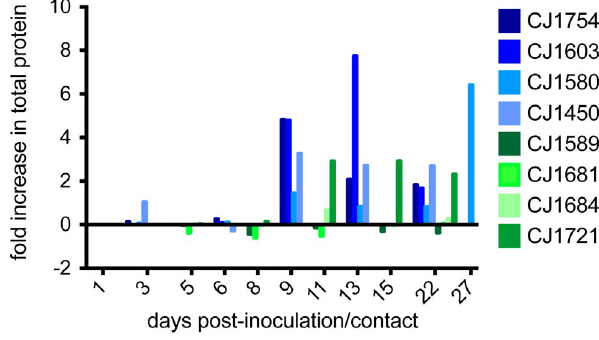
Figure 4. Protein is secreted into BAL fluid as influenza infection progresses. Bradford assay was used to detect secretion of proteins into the lungs as an indicator of damage to lung tissue. Values were normalized to protein levels detected on the first day BALs were collected. Data on subsequent days are expressed as fold increase over this baseline level; therefore negative values on this scale indicate decreased protein concentration in BAL with respect to baseline. Blue bars represent index animals; green bars represent contact animals.